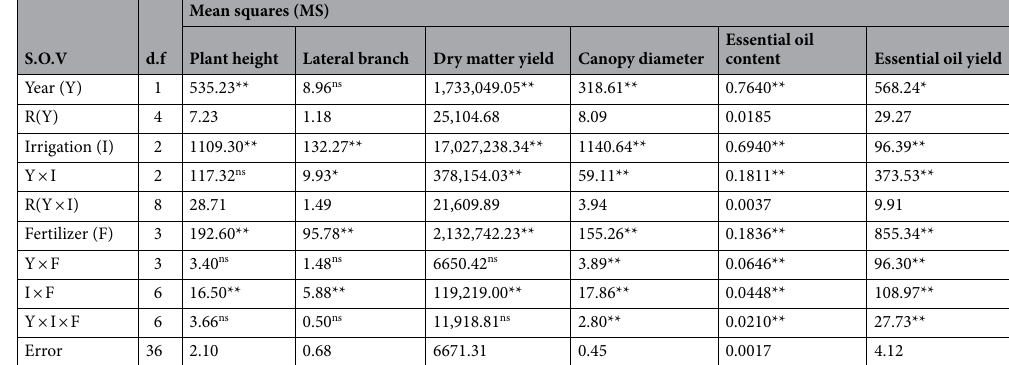
Table 3. Effects of irrigation regimes and biofertilizer application on agronomical characteristics of savory. S.O.V source of variation, R replication, d.f degree of freedom. ns, * and **: non-significant, significant at 5% and 1% probability level, respectively.